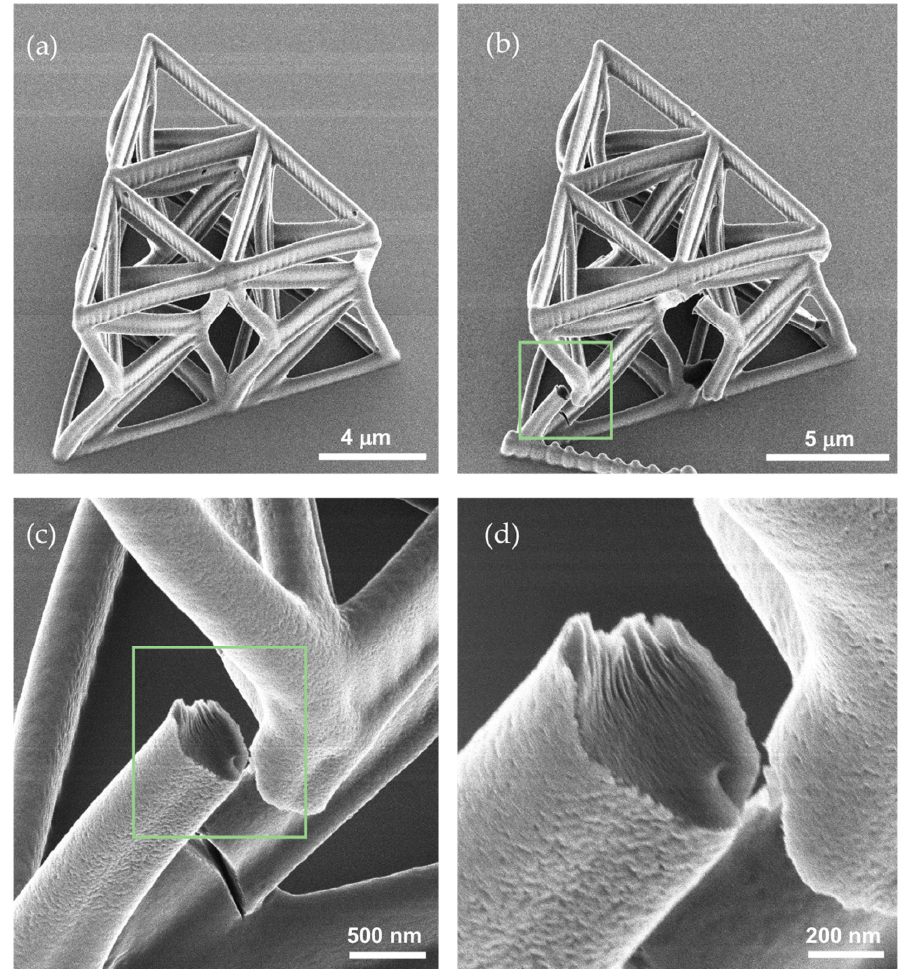
Figure 10. Helium ion microscopy (HIM) images of a three-unit array after testing. ( a ) HIM imaging of a structure that fracture did not commence. ( b , c , d ) HIM images of a fractured